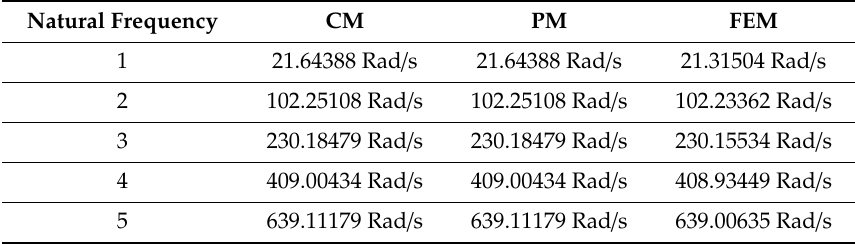
Table 2. Comparison of natural modes, 2-span beam. PM: proposed method.